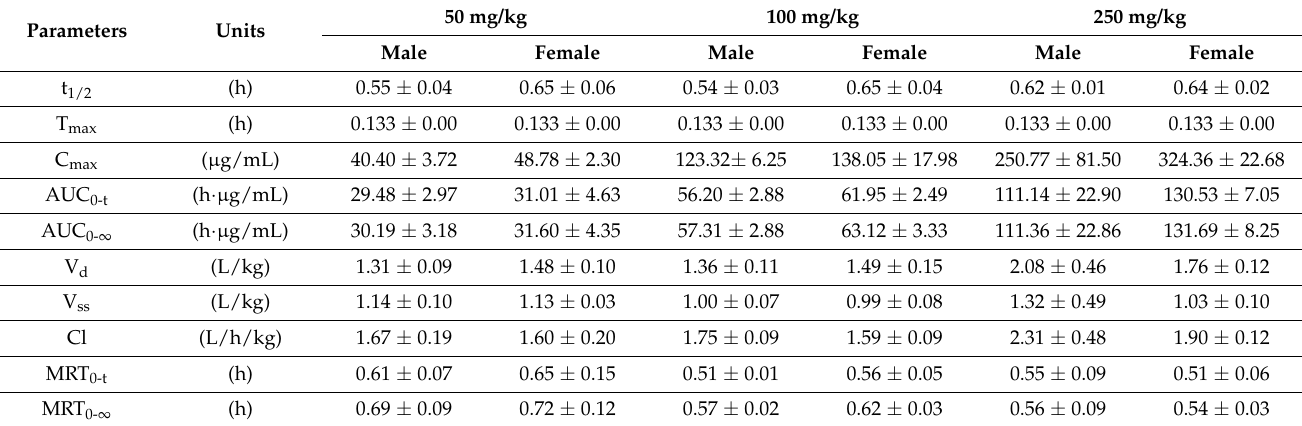
Table 5. Main pharmacokinetic parameters of GMDTC.